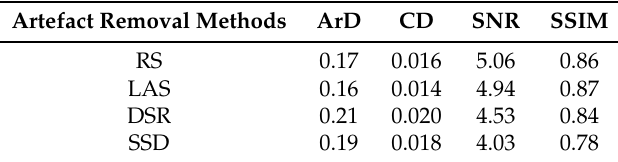
Table 2. Artefact removal